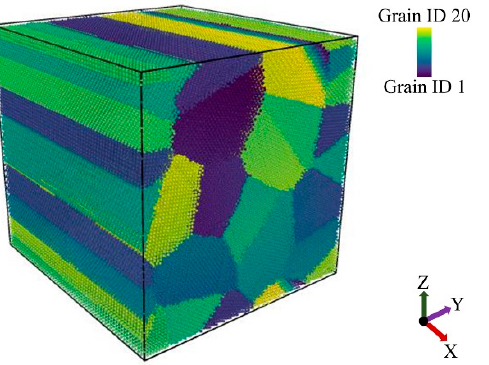
Figure 2. The polycrystalline structures built for the Cu, Ni, and equimolar Cu-Ni alloy.